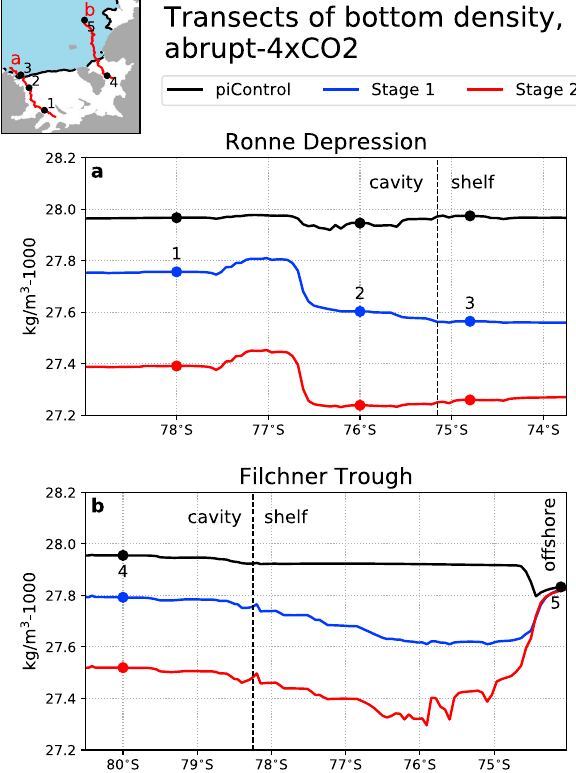
Fig. 4 Transects of potential density at the bottom of the water column in the FRIS cavity and surrounding continental shelf. a Ronne Depression; b Filchner Trough. The transects are shown in the inset map and consist of the points with the deepest bathymetry at each model latitude, within the given regions. The transects are shown averaged over three time periods: the entire piControl simulation (black), Stage 1 of the abrupt-4xCO2 simulation (years 0 – 78; blue), and Stage 2 of the abrupt-4xCO2 simulation (years 79 – 149; red). The points 1 – 5, as referenced in the text, are marked on both the density plots and the map. The dashed vertical line in each panel shows the location of the ice front. South of this line is the ice shelf cavity, and north of this line is the continental shelf. A small amount of the continental slope and offshore region is shown in the northernmost extent of ( b